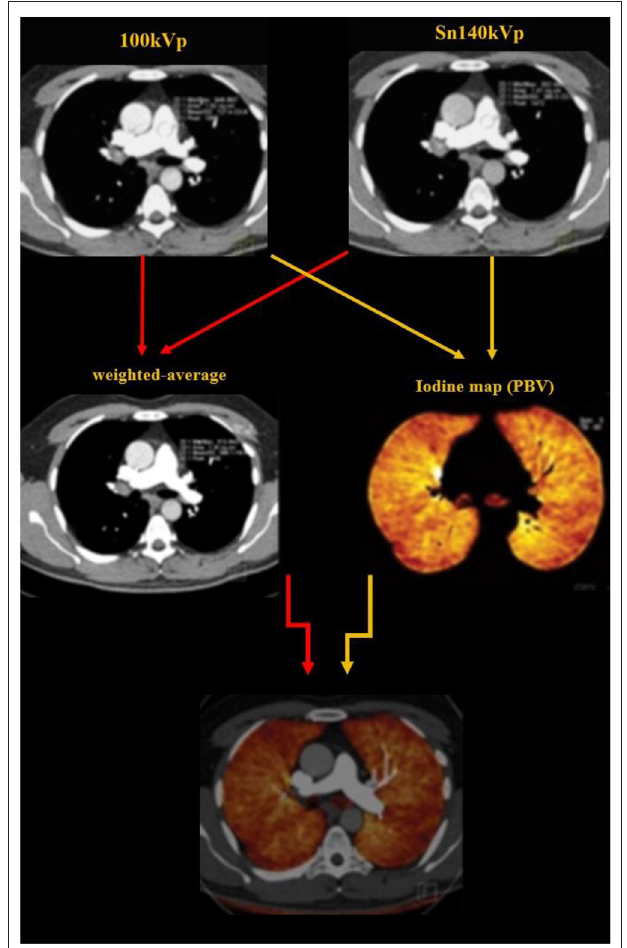
FIGURE 2 | Image reconstruction was performed as three sets of images: 140-kV images, 100-kV images, and weighted-average images (with 60% and 40% weighting from Sn 100 kVp and Sn 140 kVp image series, respectively). The dual energy algorithm measures the attenuation in each voxel and uses the known standard attenuation ranges for the three major components of the lung parenchyma including the air, soft tissue and iodine, to calculate the relative contribution of each component to the voxel attenuation. The iodine distribution maps are subsequently created by the software.